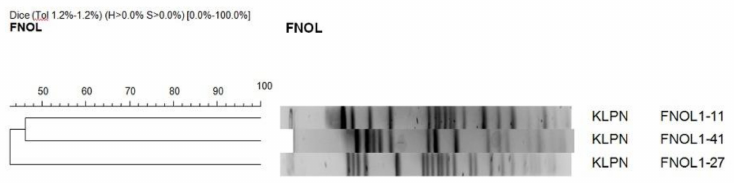
Figure 2. Pulsed-field gel electrophoresis (PFGE) of 3 CTX-M-15-positive Klebsiella pneumonia strains.